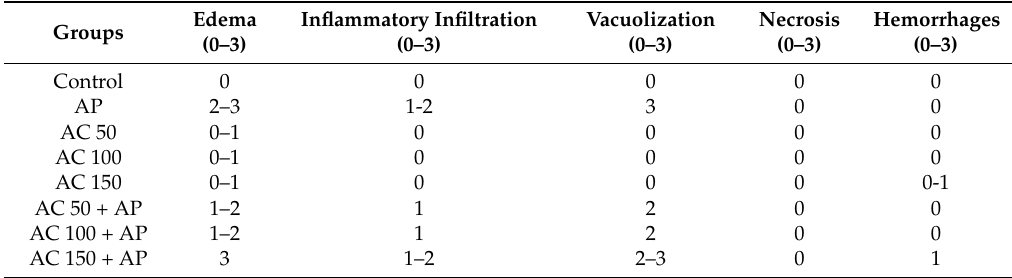
Table 1. Impact of pretreatment with acenocoumarol on histological signs of pancreatic damage in rats with or without cerulein-induced